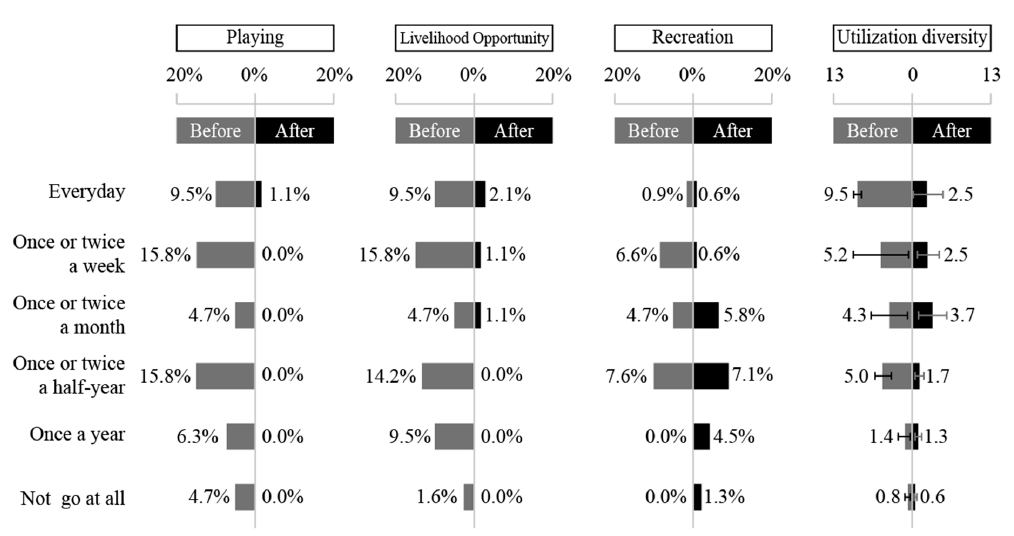
Figure 10. Ratio of answers to “no change in the Fukushima-gata lagoon before and after the reclamation project”.